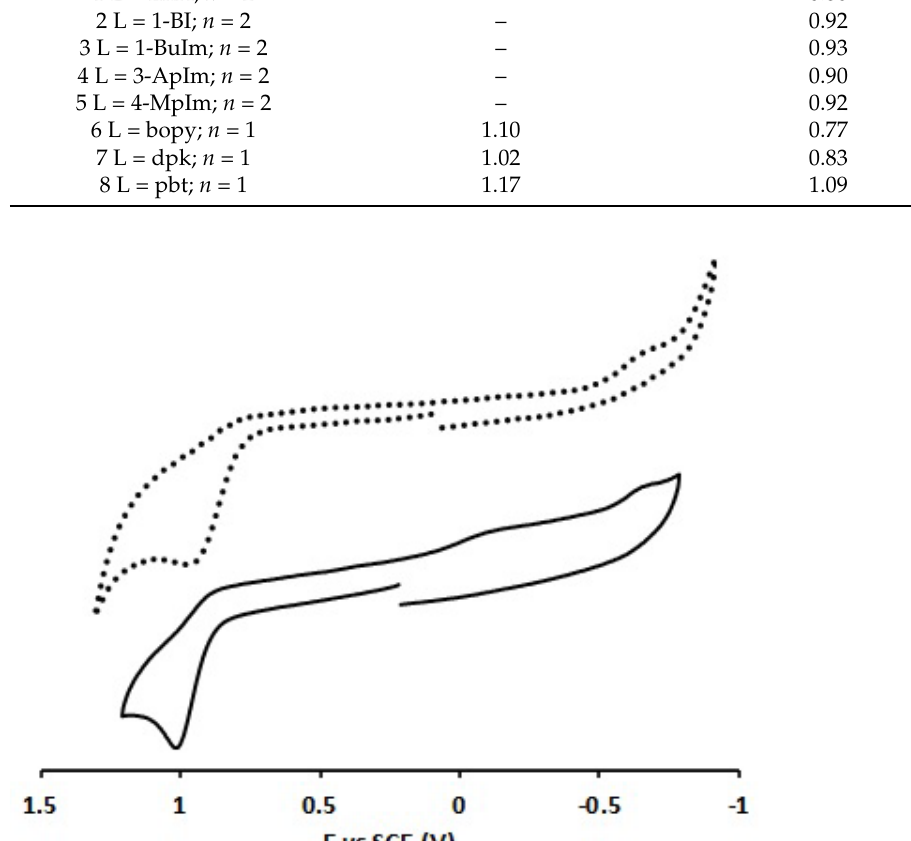
Figure 3. Cyclic voltammograms of complex [Ru( η 5 -C 5 H 5 )( m TPPMSNa)(bopy)][CF 3 SO 3 ] 6 in dichloromethane at 200 mV.s − 1 (___) with a Pt-disk WE and in HEPES buffer medium at 50 mV.s − 1 ( . . . . . . .) with a GC disk